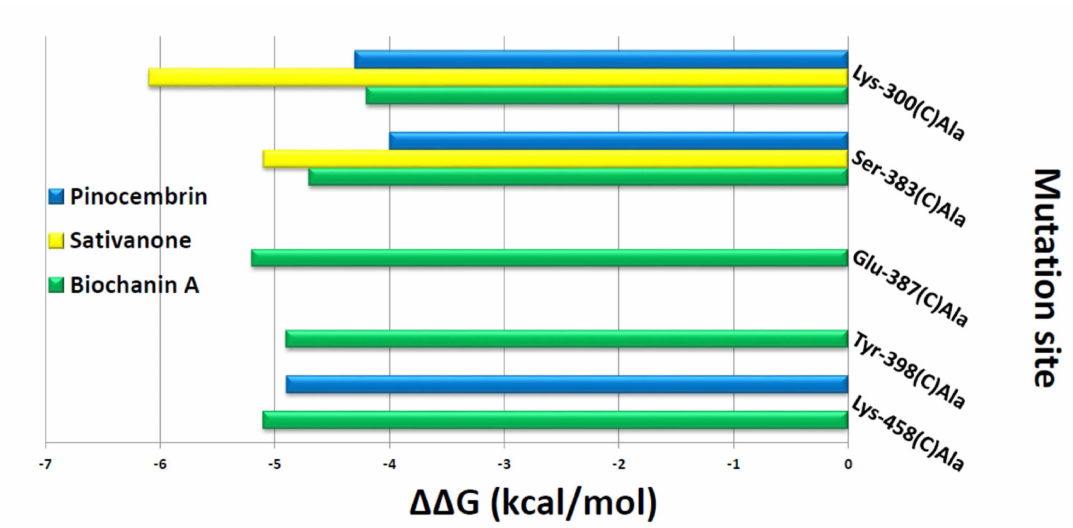
Figure 9. In silico alanine-scanning mutagenesis. Binding energy change values ( ∆∆ G = ∆ G wild- type— ∆ G Ala) obtained from the computational analysis of the K Ca 1.1 channel in a complex with biochanin A, pinocembrin, and sativanone. ∆∆ G values (kcal/mol) and the alanine-scanning muta- genesis of K Ca 1.1 channel-binding residues (involved in hydrogen bonds) in complex with biochanin A, pinocembrin, and sativanone are reported on the x - and y -axis, respectively. Negative ∆∆ G values indicate an unfavourable substitution for alanine in the relevant